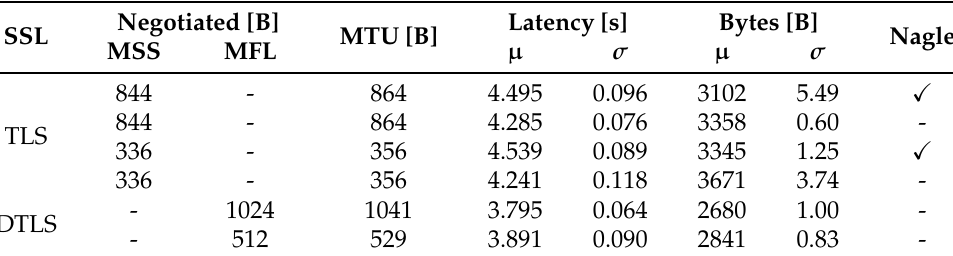
Table 2. Impact of the Maximum Transmission Unit (MTU) on the (D)TLS handshake.